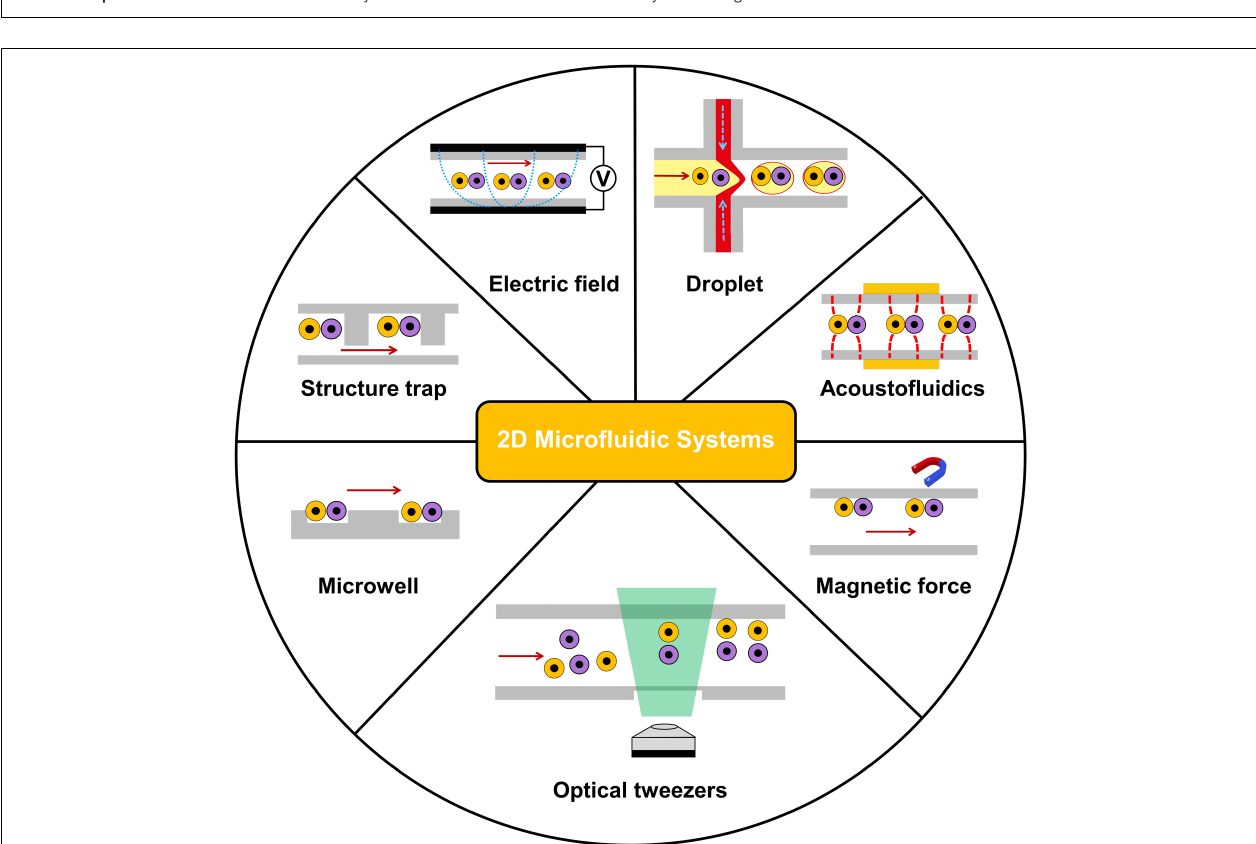
FIGURE 2 | Overview of 2D microfluidics-based systems for intercellular interaction study at the single-cell level. 2D microfluidic systems are classified based on different cell positioning methods: microwell, structure trap, electric field, droplet, acoustofluidics, magnetic force, and optical tweezers.